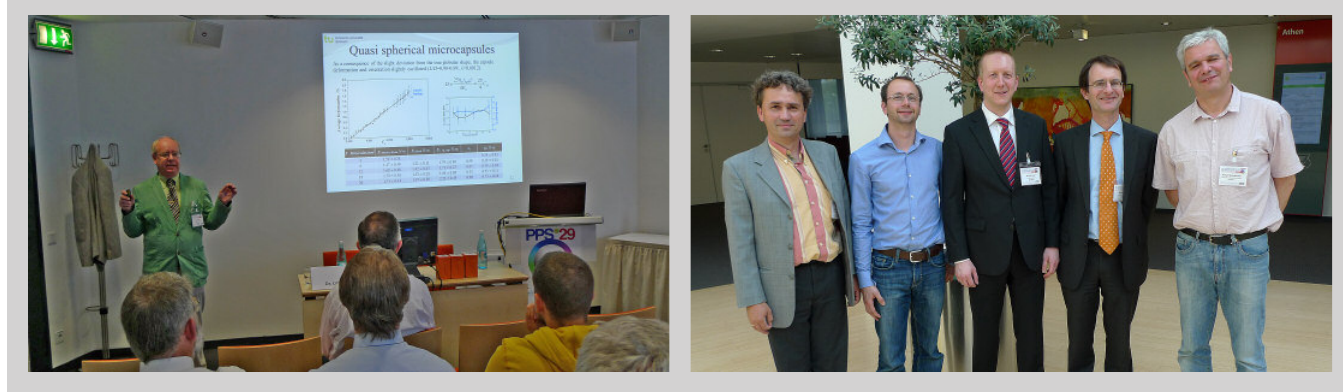
Figure 1 (left): Heinz Rehage gave a keynote lecture on deforma- tion phenomena of micro- capsules in shear flows. Figure 2: The laureates of the award of the German Rheological Society (DRG), their supervi- sors, and the President of the DRG. From left to right: Günter Auernhammer, Mar- cel Roth, Michael Kempf, Manfred Wilhelm, and Nor- bert